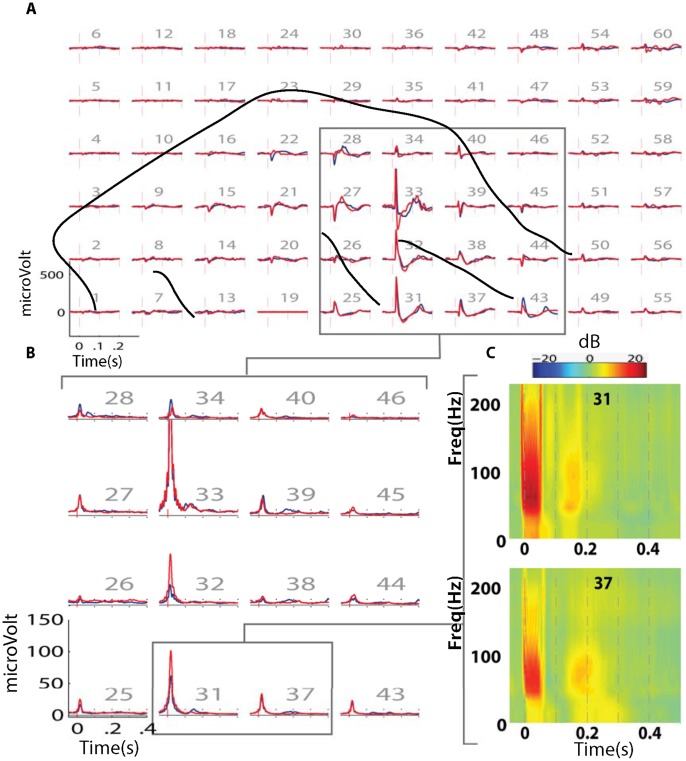
Sheep 1: Event related cortical oscillations.A) Average evoked potential distribution for epidural (blue) and intradural (red) spinal cord stimulation at 0 mm with 5 volts. Major cortical sulci are denoted by dotted lines. B) Time-varying high-gamma band (75–150 Hz) envelope for epidural (blue) and intradural (red) spinal cord stimulation in selected channels. C) Time-Frequency analysis of two representative channels during epidural stimulation. The y-axis denotes frequency in hertz and the x axis denotes time in seconds centered at stimulus onset. The color scale represents relative power change with respect to pre-stimulus values in decibels (dB).